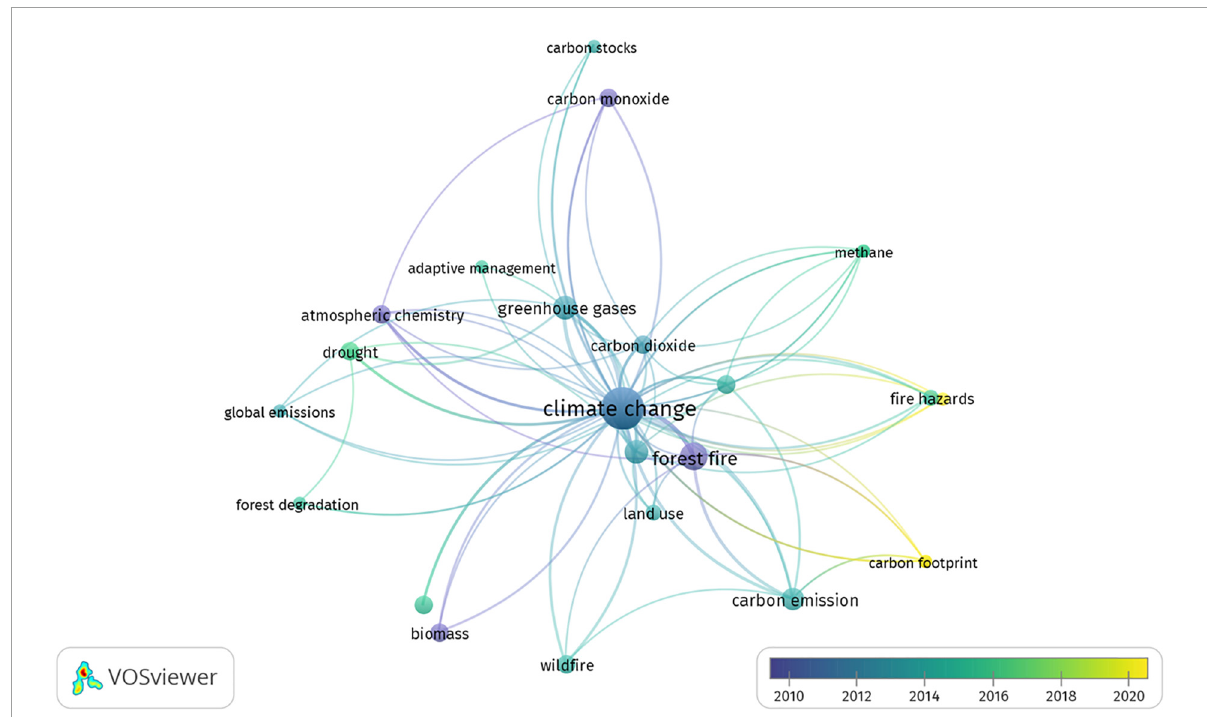
FIGURE1 Keywords correlation map using VOS viewer software (Database: scopus and number of articles: 250 documents).